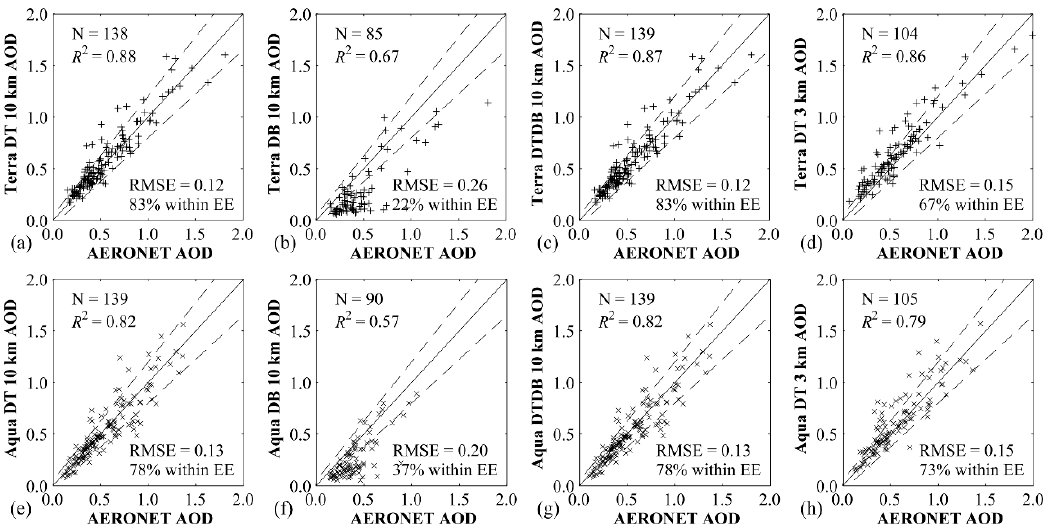
Figure 2. Validation of different Terra ( a – d ) and Aqua ( e – h ) MODIS AOD products against AERONET measurements. Dashed lines represent the expected error (EE) of ±(0.05 + 0.15 AOD), and solid lines represent the one-to-one relationships.